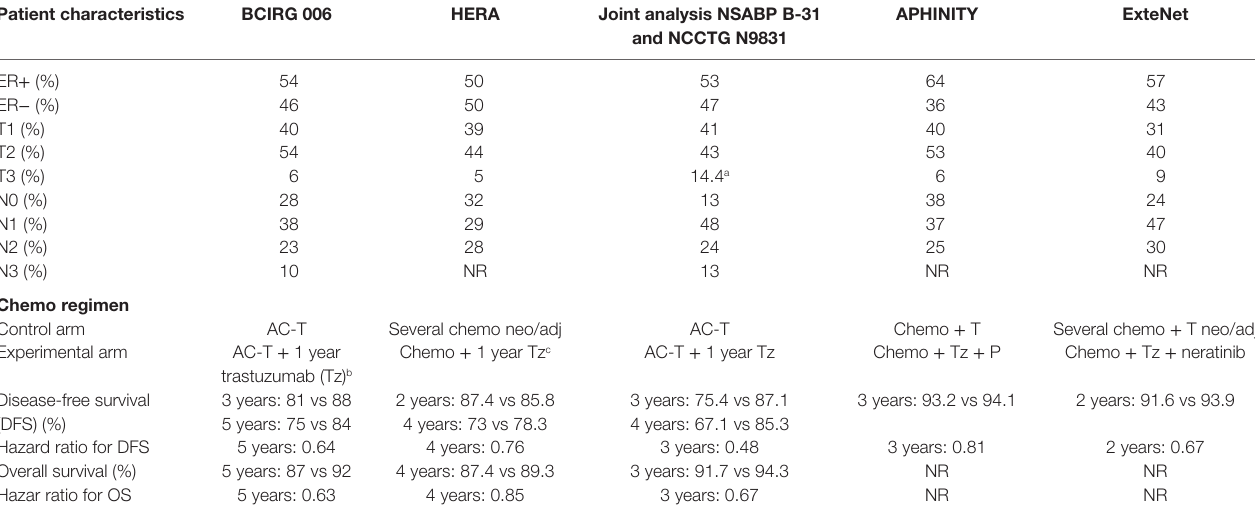
TABLE 1 | Selected adjuvant HER2 trials. patient characteristics